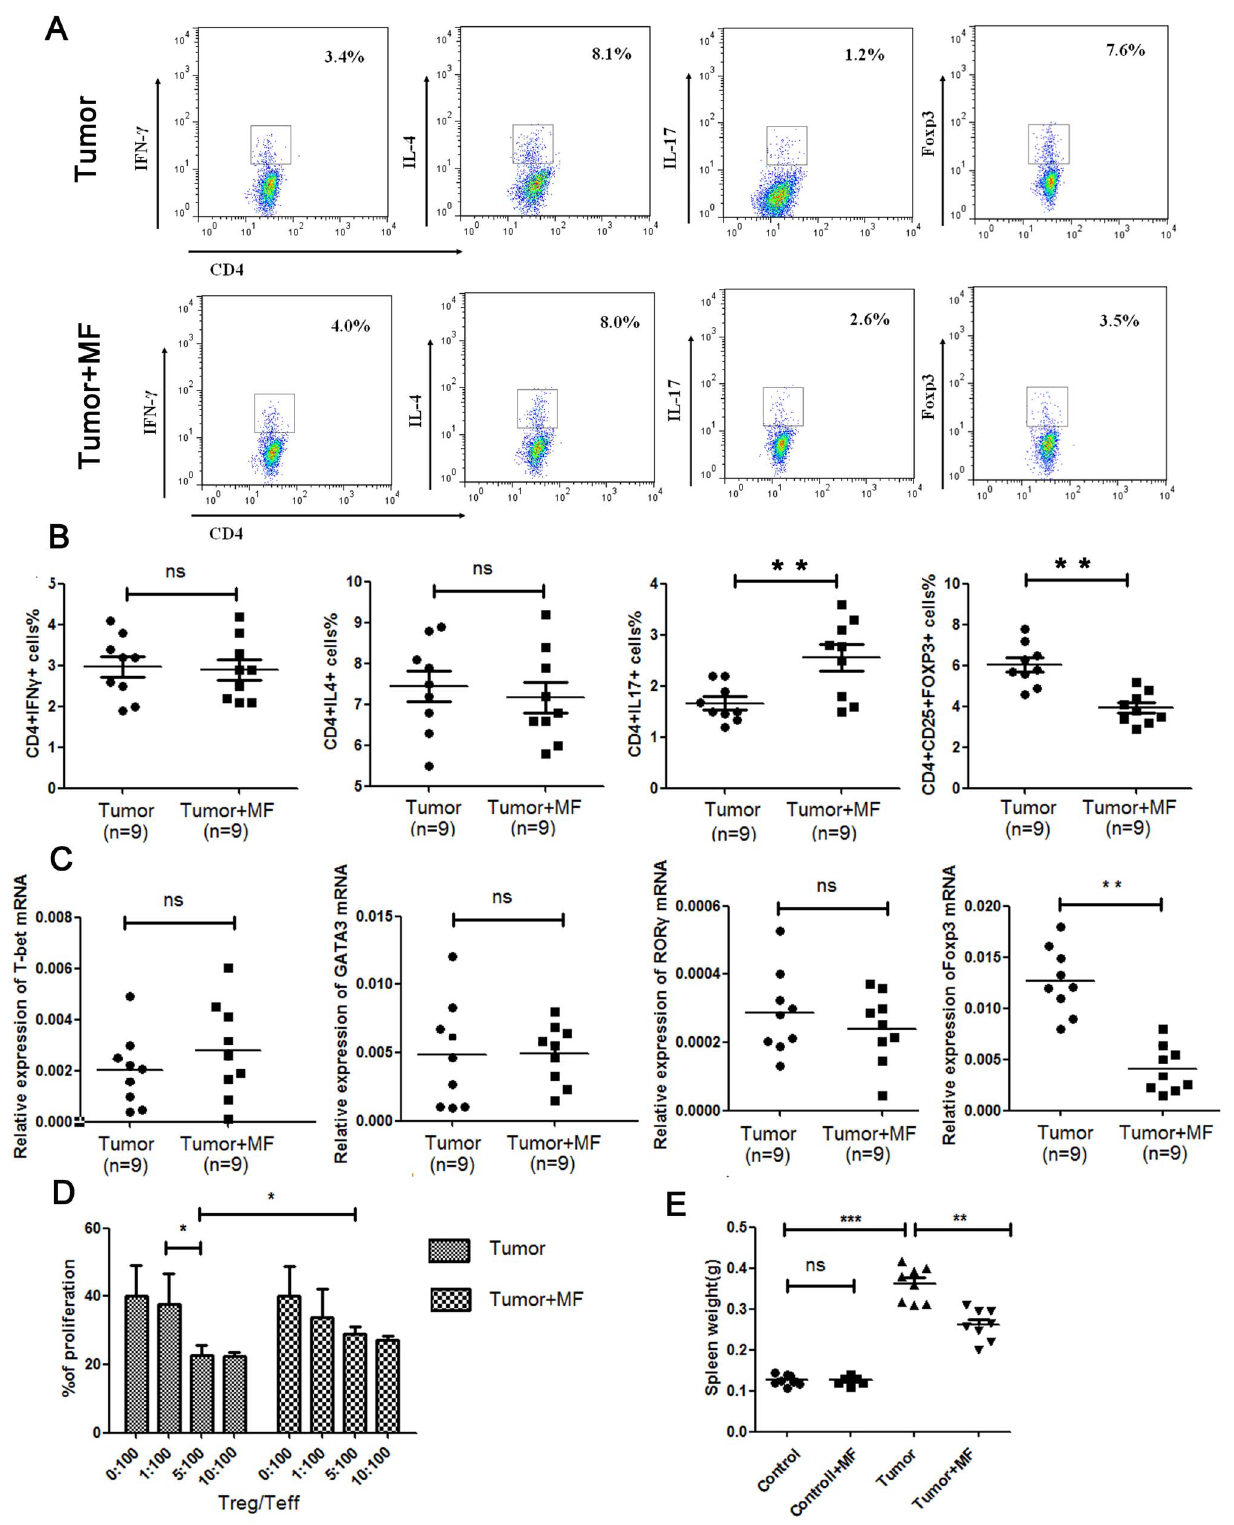
Figure 6. Magnetic fields promotes the development of CD4 + and CD8 + T cells polarization in PBMC. (A) Proportion of CD4 + T cells in PBMC was detected by flow cytometry. (B) The mean proportion of CD4 + T cells in PBMC for each group (Mean 6 s.e.m.). (C) Proportion of CD8 + T cells in PBMC was detected by flow cytometry. (D) The mean proportion of CD8 + T cells in PBMC for each group (Mean 6 s.e.m.). * P , 0.05.